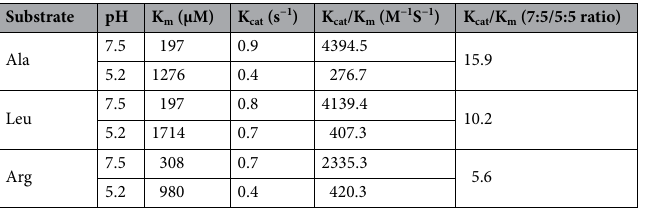
Table 2. Enzyme kinetics studies with Pf